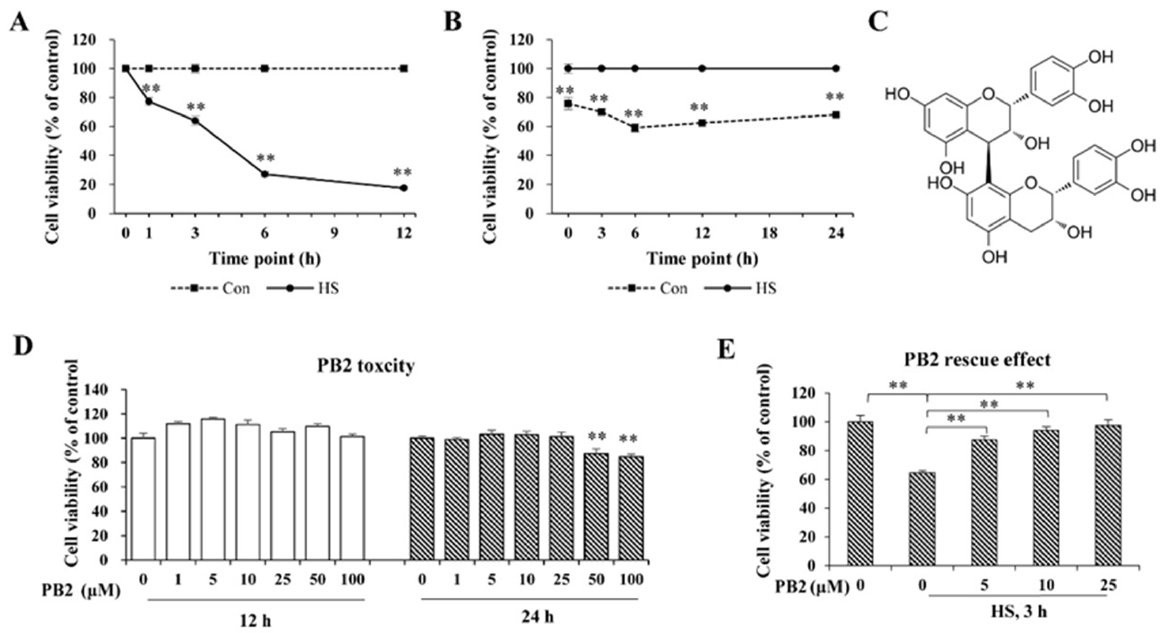
Figure 1. Effect of HS and PB2 on MAC-T cell viability. ( A ) Cell viability was measured in MAC-T cells that were treated with HS (42 ◦ C for the indicated time periods) and then recovered at 37 ◦ C for 6 h. ( B ) Cell viability was measured in cells treated with HS at 42 ◦ C for 3 h and then recovered at 37 ◦ C for the indicated time periods. ( C ) Chemical structure of PB2. ( D ) Cell viability was measured in cells treated with indicated concentrations of PB2 for 12 or 24 h. ( E ) Cells were pretreated with the indicated concentrations of PB2 for 24 h, followed by HS treatment at 42 ◦ C for 3 h and recovery at 37 ◦ C for 6 h. Then, cell viability was determined. n ≥ 5. ** p < 0.01.